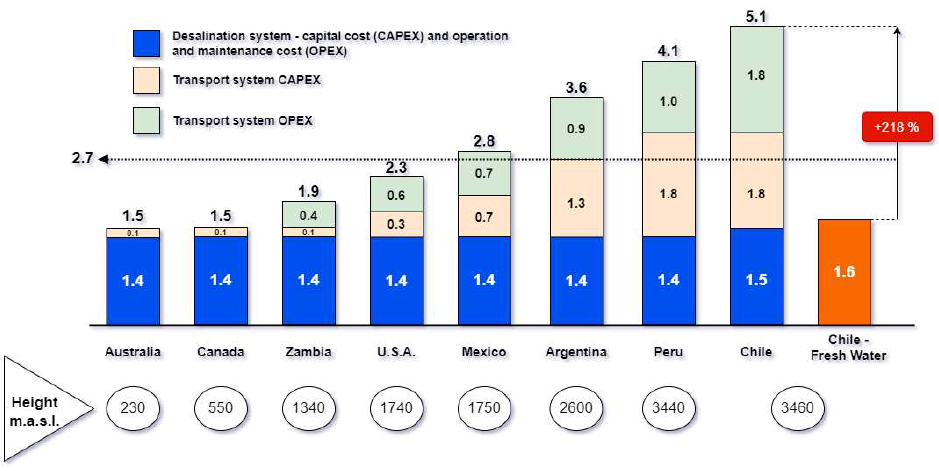
Figure 2. The cost (USD/m 3 ) of using seawater for different countries [71].